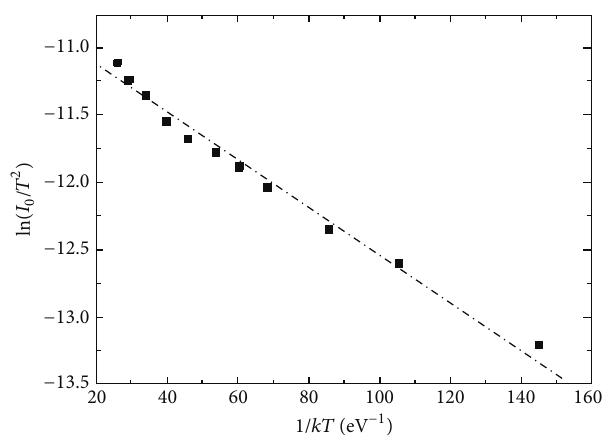
Figure 4: The conventional Richardson plot of ln (𝐼 0 /𝑇 2 ) versus 1/ kT of Al/poly(4-vinyl phenol)/ p -GaAs